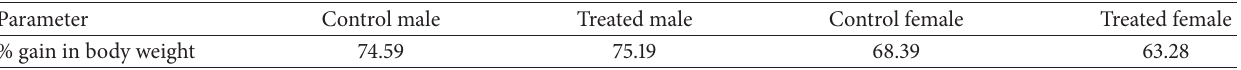
Table 2: Effect of Shaqeeqa on body weight of female rats.